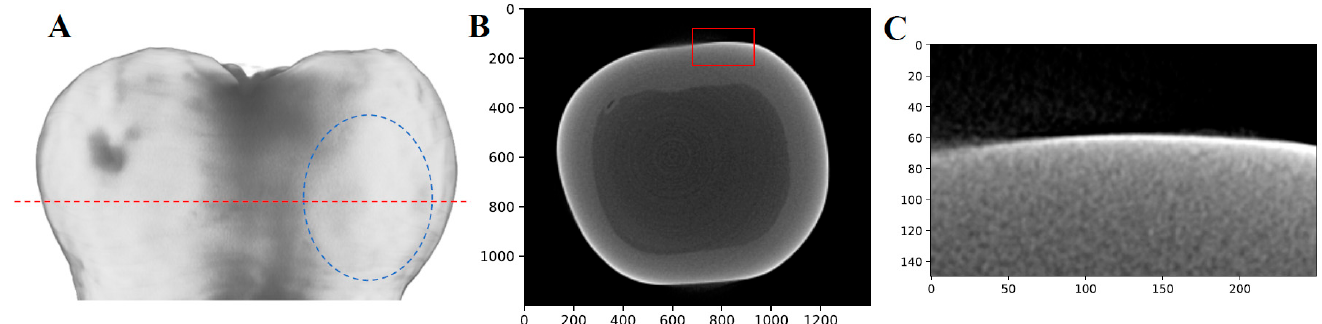
Figure 12. μ -CT results of sample M8 (8 days of demineralization): ( A ) Volume reconstruction with no visible lesion. The dashed blue oval indicates the region where the lesion is visible with the naked eye, the dashed red line indicates the plane where the transverse view B is taken. ( B ) Transverse view of the sample with the red box indicating where the lesion should be visible. ( C ) Enlarged view of the red box seen in B, with no lesion visible.